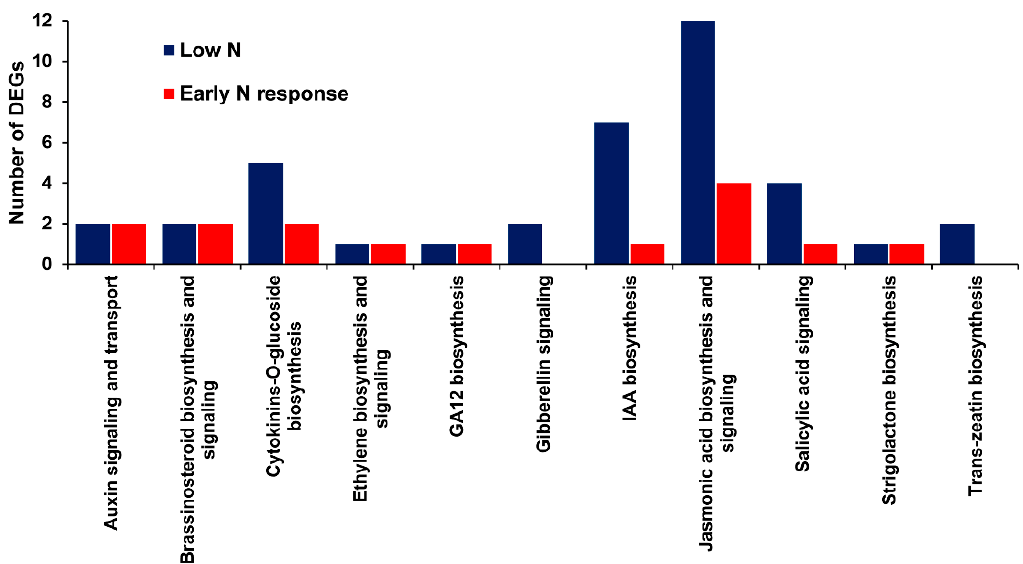
Figure 8. Number of DEGs identified related to phytohormone signaling during various nitrogen conditions. The plant hormone signaling genes identified were obtained from the combined data of low N (PKLN vs. PKFN, PKLN vs. BGLN and BGLN vs. BGFN) and 1-h response/early N response (PK1H vs. PKLN, PK1H vs. BG1H and BG1H vs. BGLN).